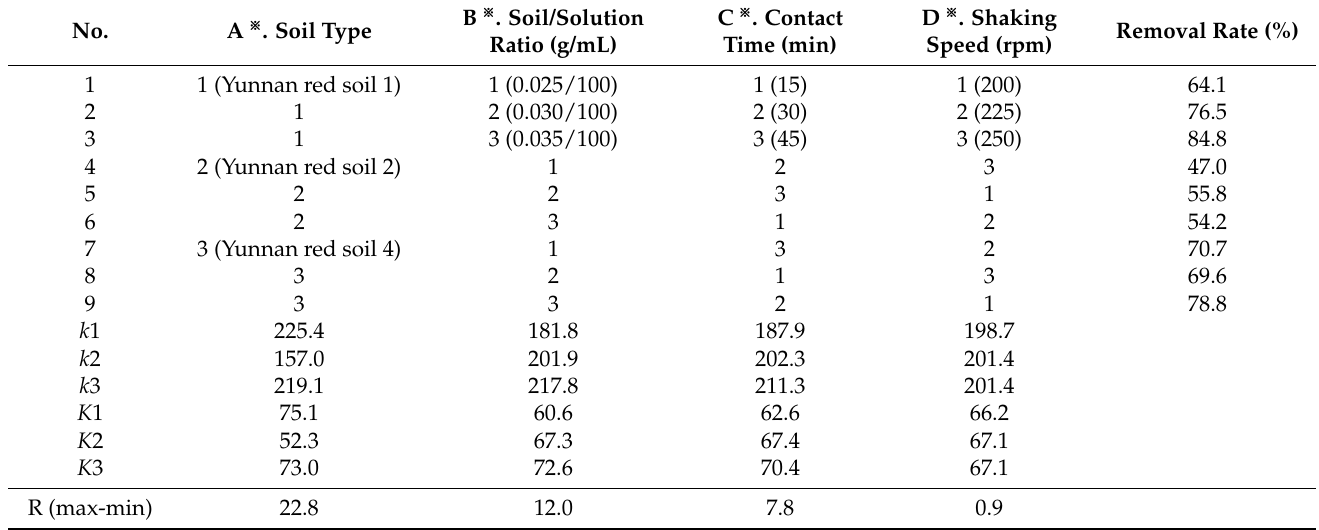
Table 3. The L 9 (3 4 ) Orthogonal Array Experimental Design and Arsenate Removal Efficiency As